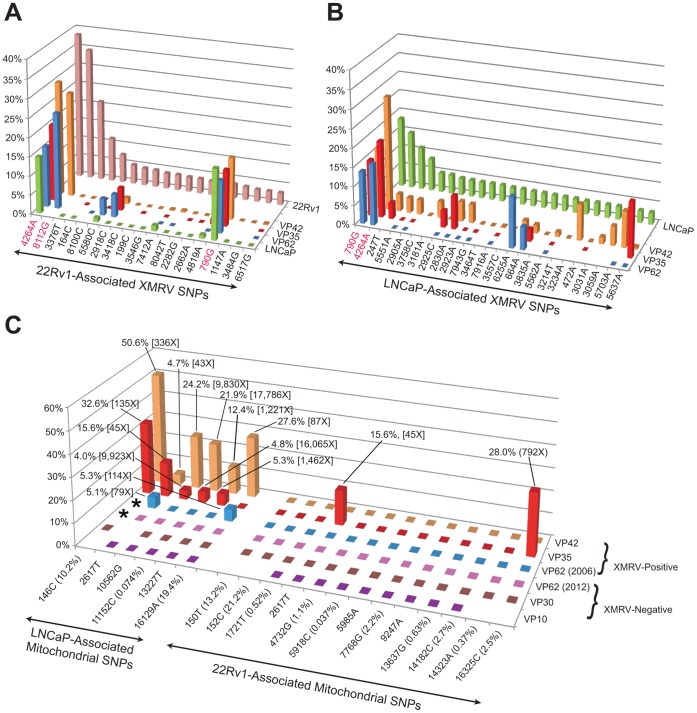
Evidence for Contamination of Prostate Cancer Tissues by XMRV-Infected LNCaP Cells.SNP analysis of deep sequencing reads corresponding to the XMRV genomes of 22Rv1 (A) and LNCaP (B), as well as the mitochondrial genomes of these two cell lines (C) was performed. (A and B) SNP variants within the XMRV genome for 22Rv1 and LNCaP (x-axis) are shown in order of decreasing frequency (y-axis). Shared SNPs in XMRV genomes corresponding to 3 XMRV-positive prostate cancer samples (VP35, VP42, VP62) and LNCaP (z-axis) at a frequency cutoff of 0.5% are plotted on the graph, with key SNPs highlighted in red. SNPs with variant frequencies <0.5% are plotted as zero; missing values (blank squares) refer to SNP positions for which the coverage is <10X. (C) SNP variants within the mitochondrial genome for 22Rv1 and LNCaP are shown (x-axis), with the frequency of each 22Rv-1−/LNCaP-associated SNP in the general human population, as determined by a population-level human mitochondrial database [50], given in parentheses. For each prostate cancer-associated mitochondrial genome (z-axis), the minority SNP frequency (y-axis) is plotted against the cell line-associated SNP variant (x-axis), using a frequency cutoff of 3%. For each minority SNP identified, the variant frequency and coverage at the corresponding nucleotide position is shown. Minority SNPs with variant frequencies <3% are plotted as zero; missing values (blank squares) refer to SNP positions for which the coverage is <30X. Note that the VP62 sample shares a 146C mitochondrial SNP with LNCaP (asterisks).